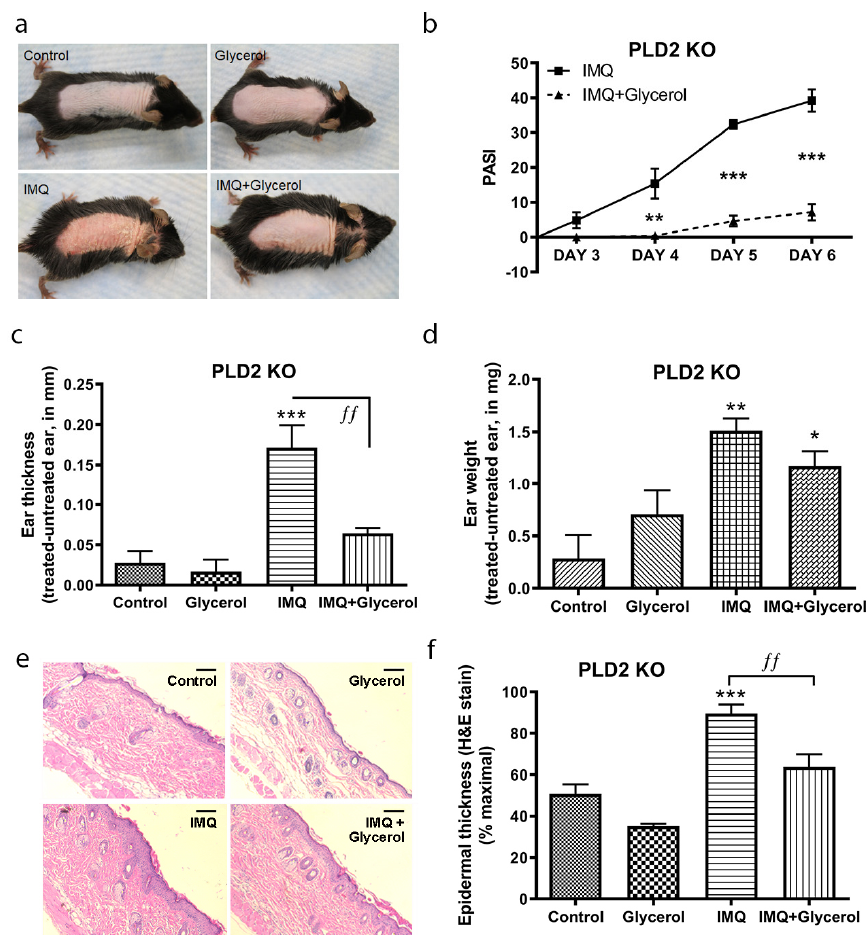
Figure 2. Topical glycerol improved IMQ-induced psoriasiform lesions in PLD2 knockout mice. As in Figure 1, IMQ or vehicle and water or glycerol (as a 50% glycerol in water solution) were applied topically to PLD2 knockout mice (on a C57BL/6 background). ( a ) Representative photographs (day 6) showing effects on epidermal erythema, thickening and scaling with treatments. ( b ) Psoriasis area severity index (PASI) scores analyzed by unpaired, two-tailed t-tests comparing two groups within the same day. ( c ) Ear thickness and ( d ) ear weight measured as described in Methods. ( e ) Representative H&E-stained micrographs showing back skin epidermal thickening with IMQ treatment (scale bar = 100 µ m). ( f ) Quantitation of the thickness expressed as the percent maximal value, presented as means ± SEM ( n = 4–5), with ANOVA followed by Student–Newman–Keuls multiple-comparison post-hoc tests used to determine significant differences; * p < 0.05, ** p < 0.01, *** p < 0.001 versus control; ƒƒ p < 0.01 as indicated; n = 4–5.